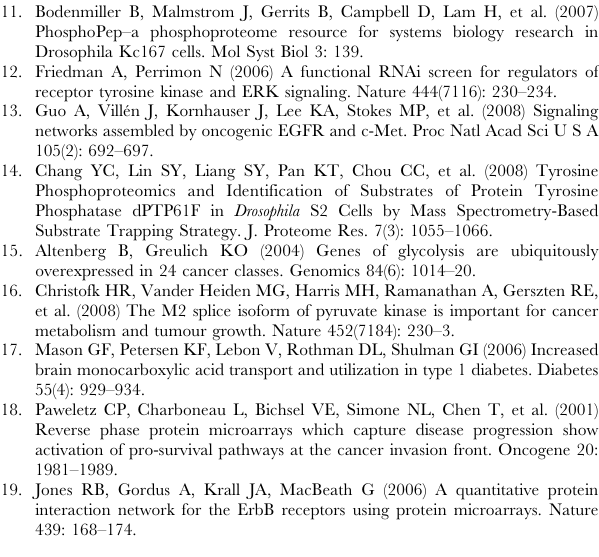
Table S3 Conserved phosphorylation sites on human proteins involved in various diseaeses. Summary of the list of putative tyrosine phosphorylation sites on various human proteins that are involved in the development of various cancers, leukemias, neurodegenerative diseases and various genetic syndromes/